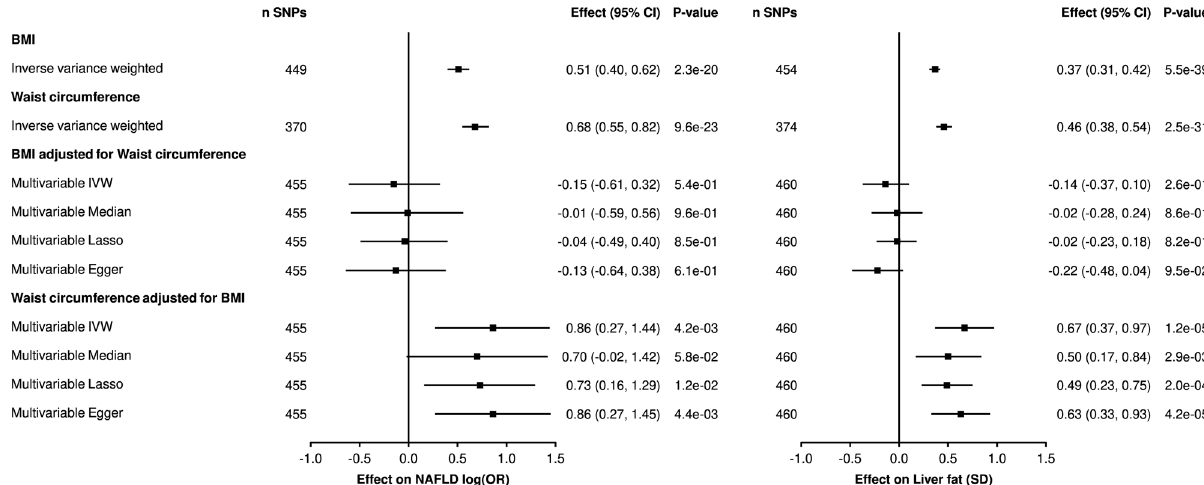
Fig. 2 Causal effect genetically predicted waist circumference and body mass index (BMI) on non-alcoholic fatty liver disease (NAFLD) and liver fat accumulation using univariable and multivariable Mendelian randomization. The association between waist circumference and body mass index (per 1-SD increase) and NAFLD and liver fat accumulation is presented using univariable inverse-variance weighted MR and multivariable MR using multiple robust methods. Error bars are 95% con fi dence interval.